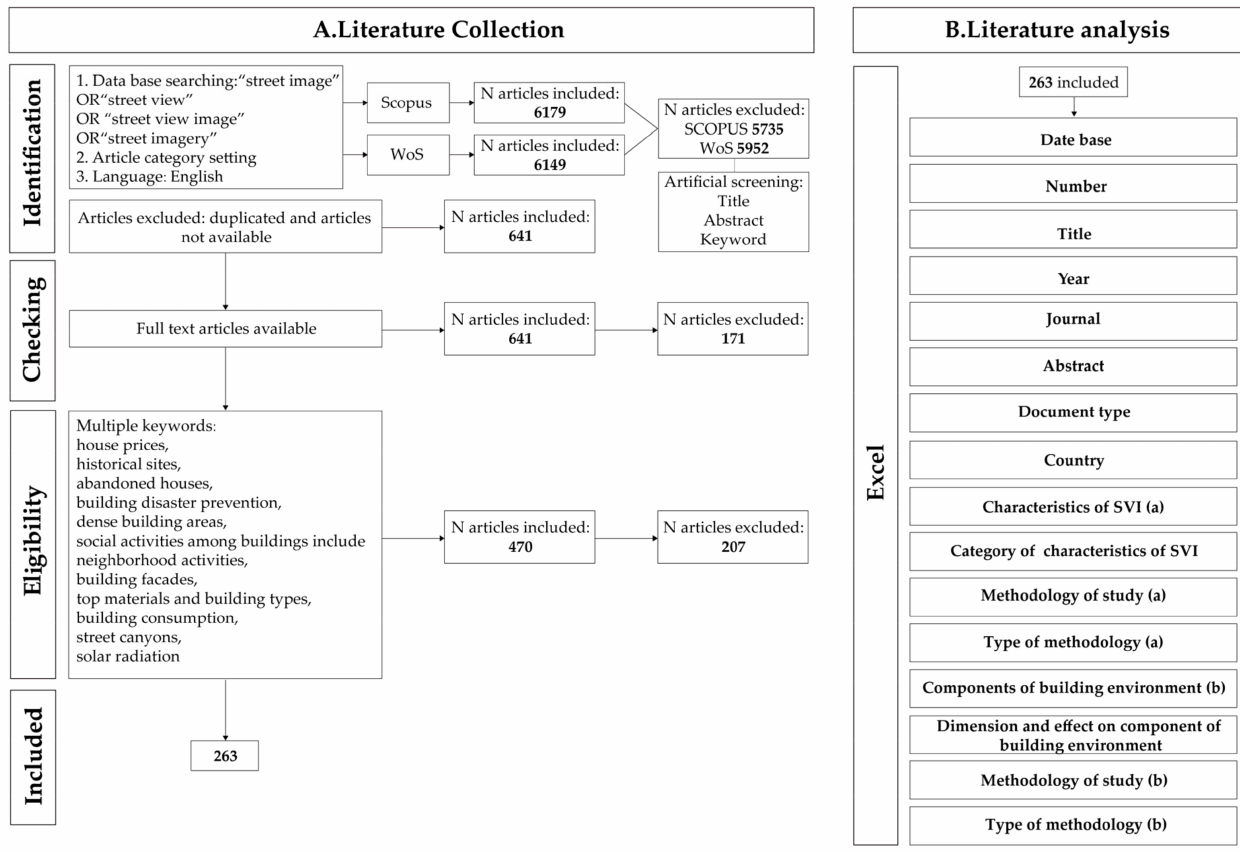
Figure 1. Literature collection process and analysis.